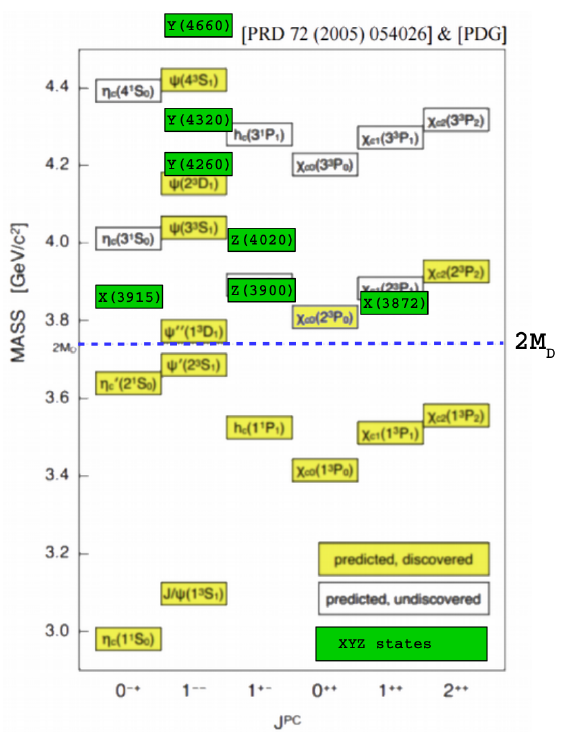
Figure 1. The charmonium spectrum in the mass (vertical axis) vs quantum number (horizontal axis) plane. XYZ are also represented in order to show graphically the abundance in the considered energy